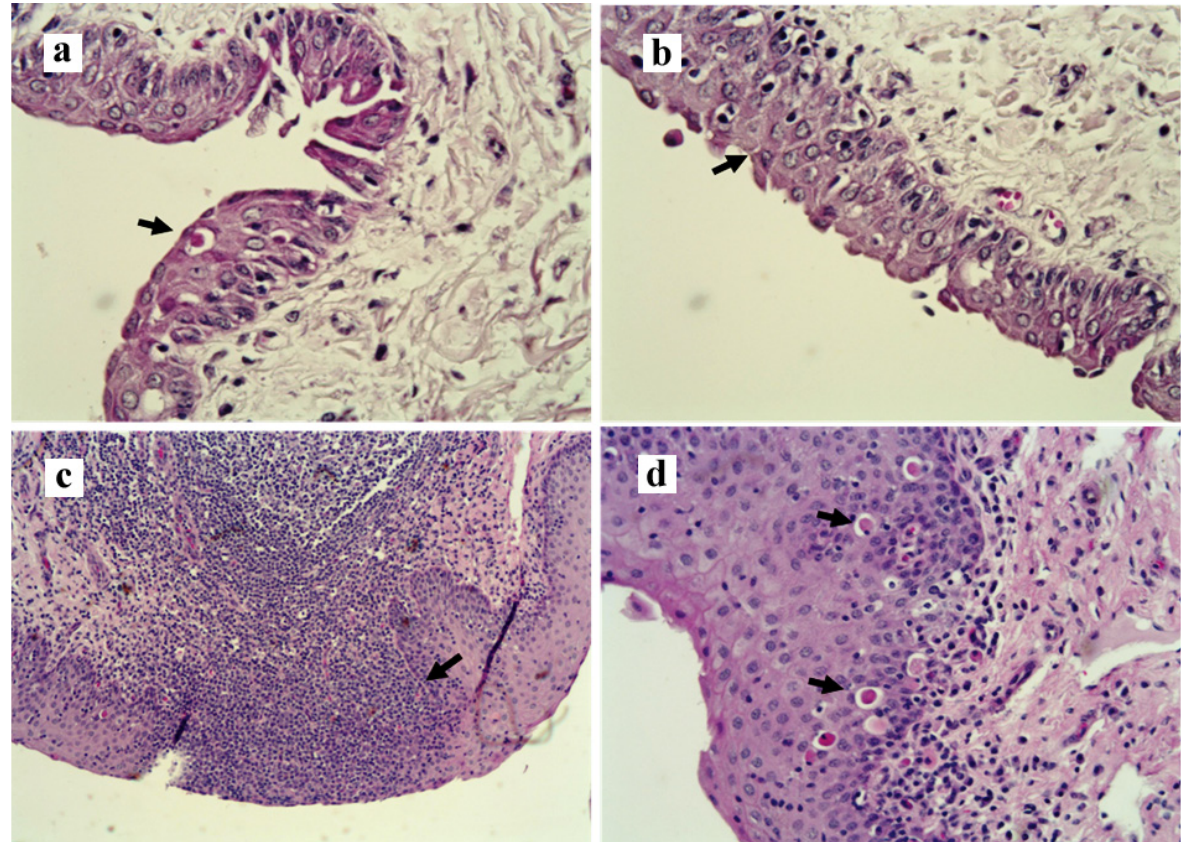
Figure 3 - Photomicrography. Panel a - Fornix, disceratosis in the epithelial cells (narrow, H&E, 400X); Panel b - Fornix, spongiosis, discrete epithelial atrophy, congestion of the lamina propria (narrow, H&E, 400X); Panel c - Vulva, submucosal diffuse infiltration of lymphocytes - exocitosis (narrow, H&E, 100X); Panel d - Vulva, disceratosis in the epithelial cells (narrow, H&E,